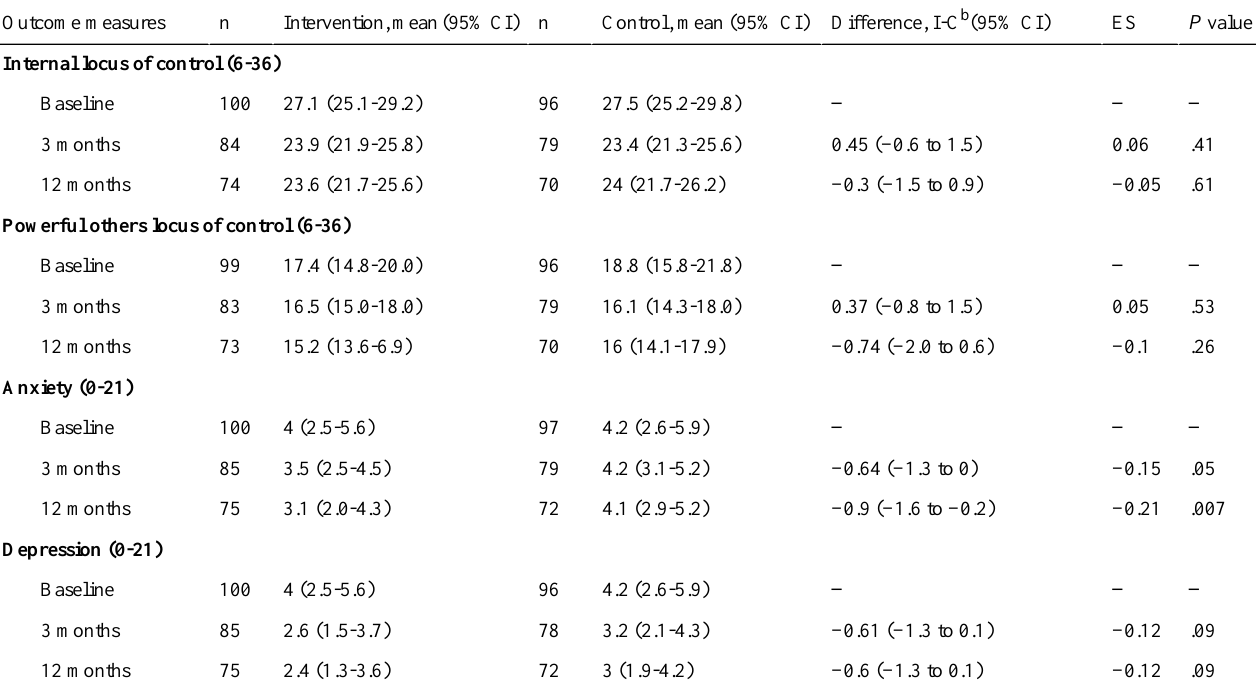
a For symptoms, quality of life, sport and recreation, self-efficacy, active pain coping, and locus of control, a higher score indicates an improvement. For sedentary behavior, tiredness, pain, passive pain coping, anxiety and depression a lower score indicates an improvement. Results are based on GEE analyses and adjusted for corresponding baseline variables, age, OA location, and gender. b I-C: difference between intervention and control